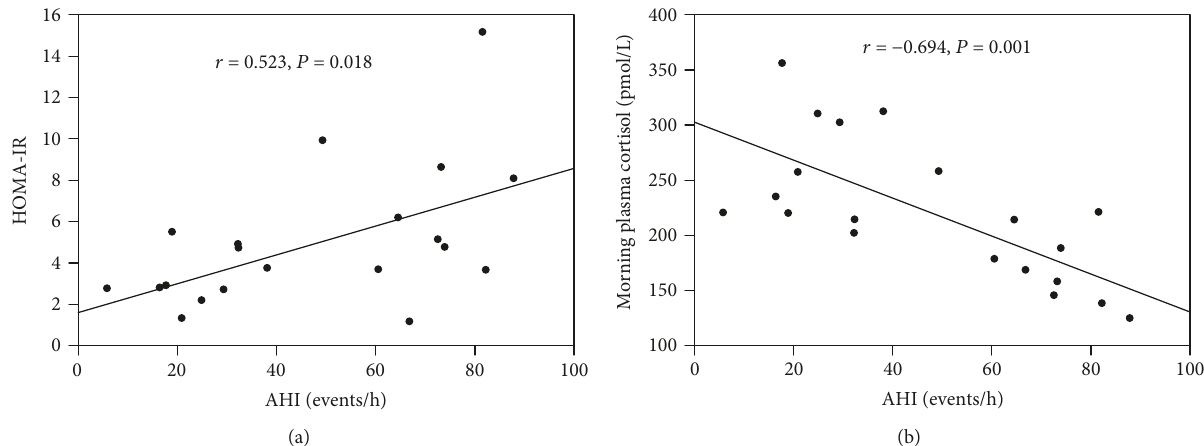
Figure 1: Correlation between AHI and HOMA-IR (a) and correlation between AHI and morning plasma cortisol (b) of OSA with T2DM patients. HOMA-IR homeostasis model assessment of insulin resistance. AHI: apnea-hypopnea